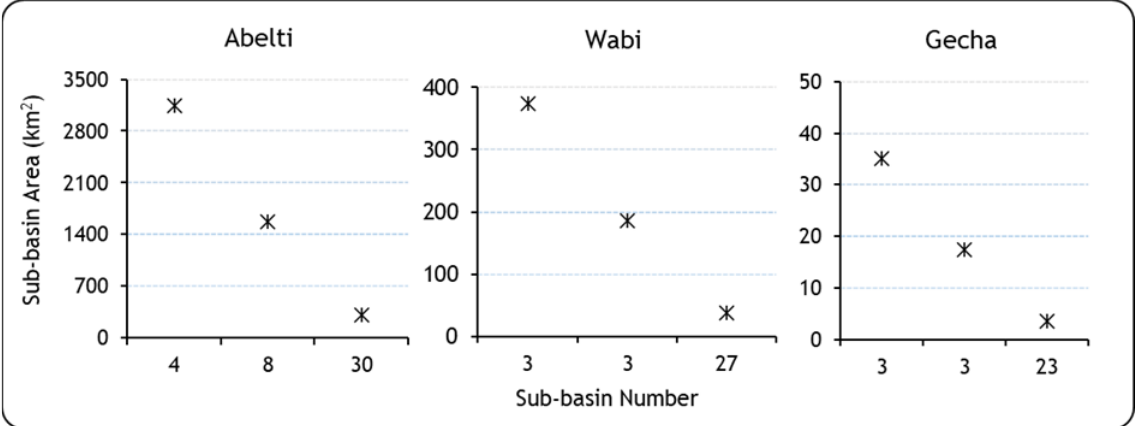
Figure 3. Variations in subbasin area and its subdivisions within the studied area.